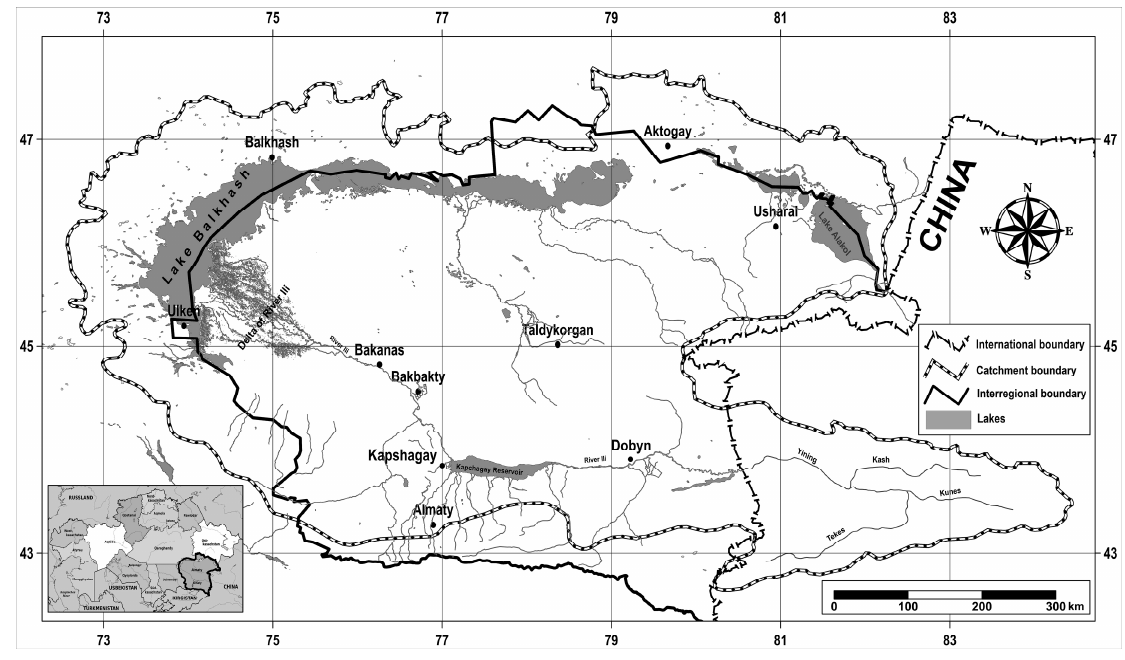
Figure 1. Map of the Ili river basin and Lake Balkhash [12].